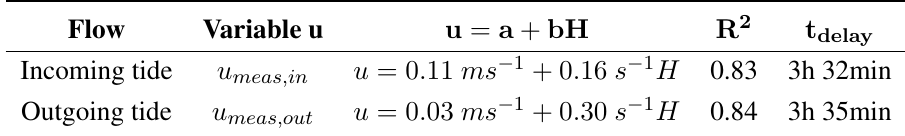
Table 6. Parameters for correlating the tidal height with the maximum velocity. t time in minutes that the maximum velocity will show after high or low